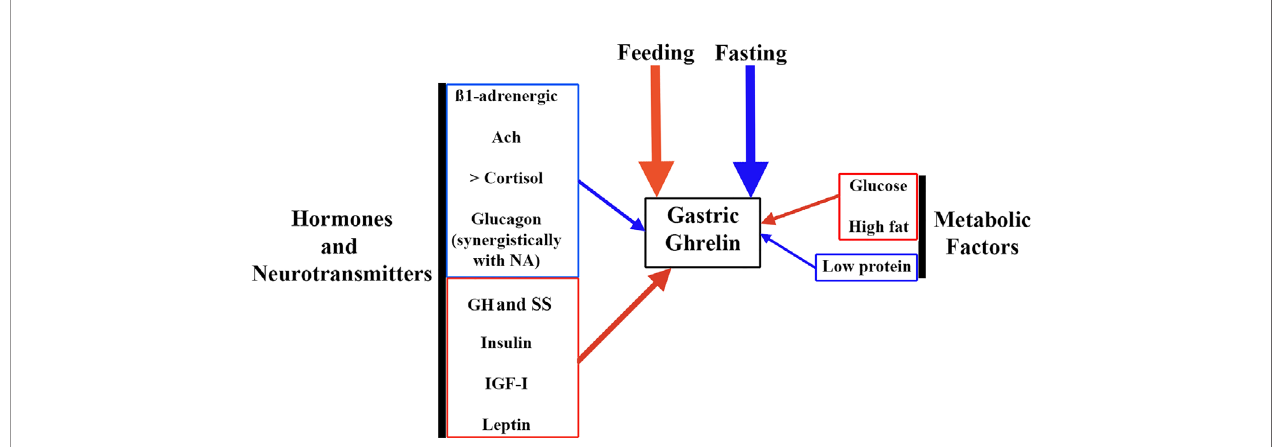
FIGURE 3 | Factors involved in the regulation of gastric ghrelin secretion. As ghrelin is an orexigenic hormone, the main factors that regulate its gastric secretion are fasting (stimulates it, blue arrow) and feeding (inhibits it, red arrow). But in addition, a series of factors such as hormones and neurotransmitters, and metabolic factors play an important role in this regulation. Among neurotransmitters, ß-1 adrenergic pathways and the cholinergic system (Ach) stimulate gastric ghrelin production (blue arrow). Among the hormones, increased plasma cortisol and glucagon levels also stimulate gastric ghrelin production, although in the case of glucagon its effect is most likely to depend on an action carried out synergistically with NA. In contrast, other hormones such as GH, SS, insulin, IGF-I and leptin inhibit gastric ghrelin production (red arrow). Among metabolic factors, glucose and high fat content inhibit gastric ghrelin production (red arrow), while low protein intake stimulates it (blue